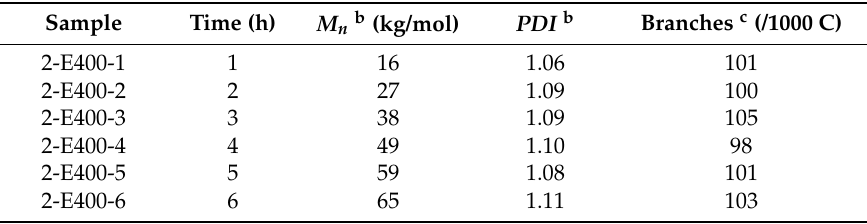
Table 1. Ethylene polymerization using 2 at 5 °C and 400 psi in chlorobenzene a .